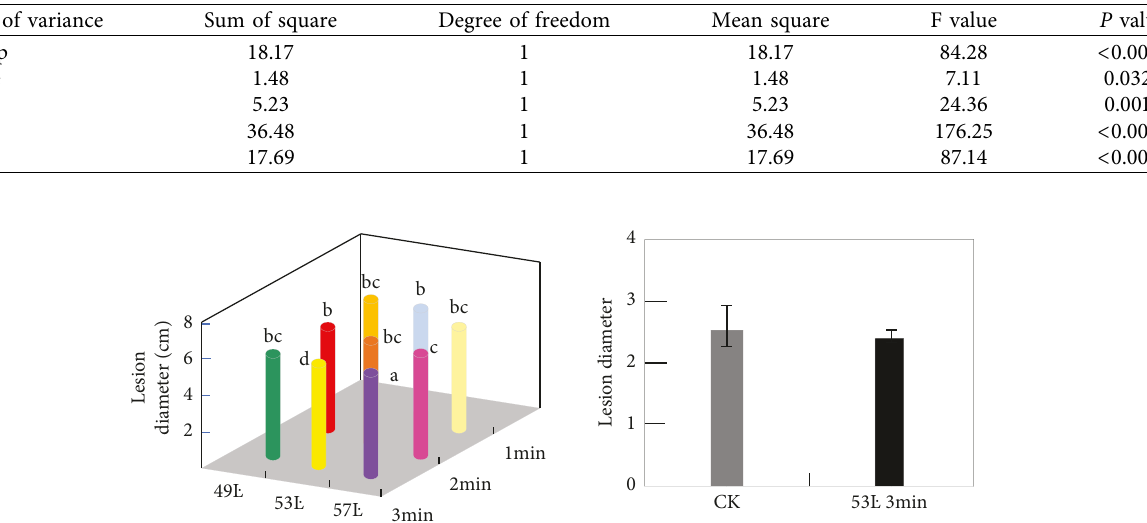
Figure 8: The effect of different heat treatment conditions on the diameter of the lesion 7 days after inoculation of fruit injury. Different letters in the figure represent significant differences ( P < 0 . 05), and the vertical line in the figure represents standard error ( ± SE).